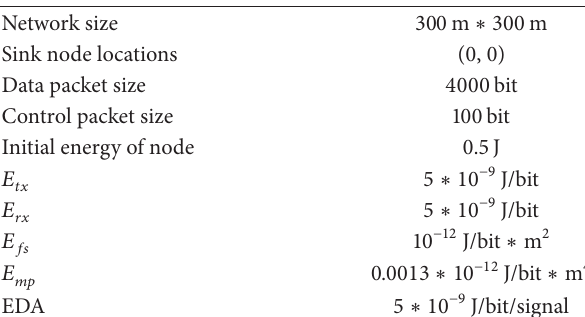
Table 1: Simulation parameters.